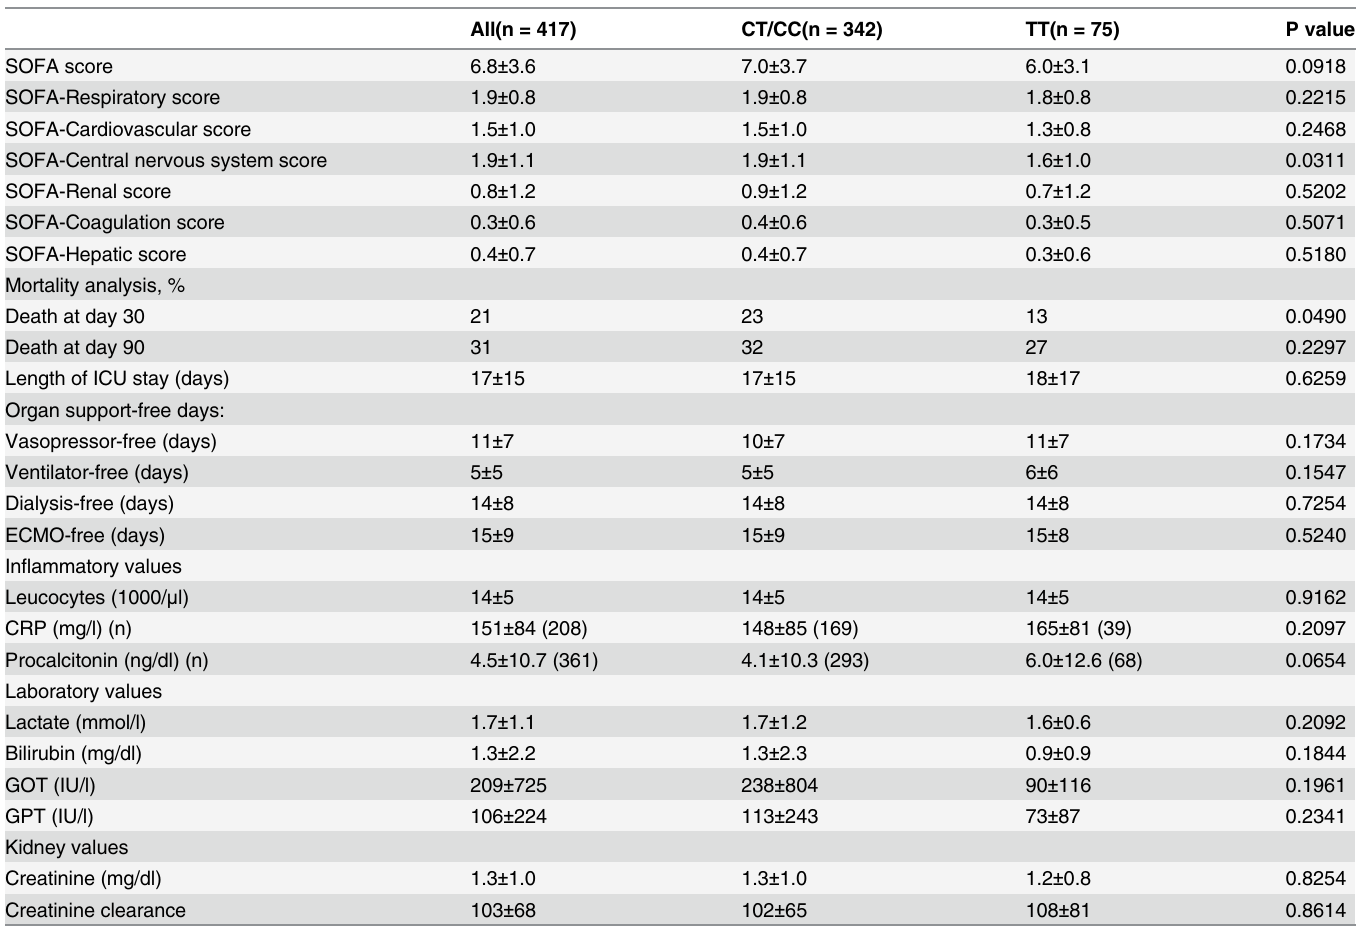
Table 2. Disease severity over the course of